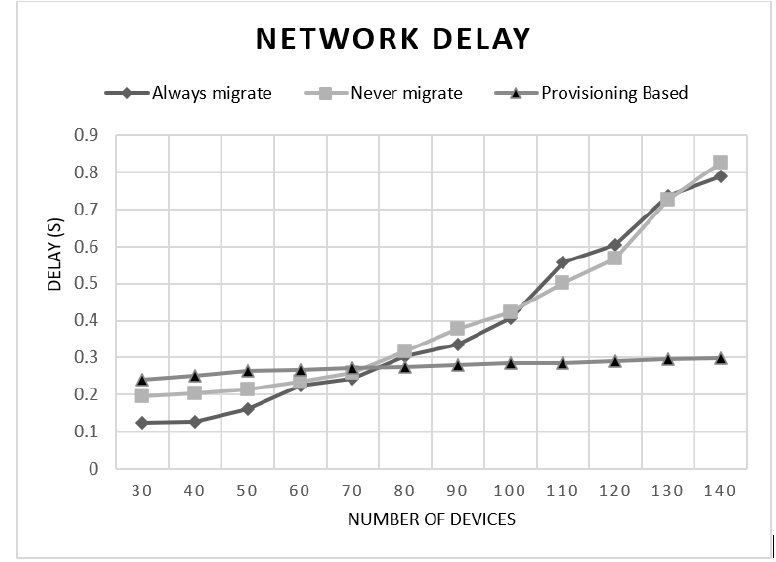
Figure 5. Network average delay for different